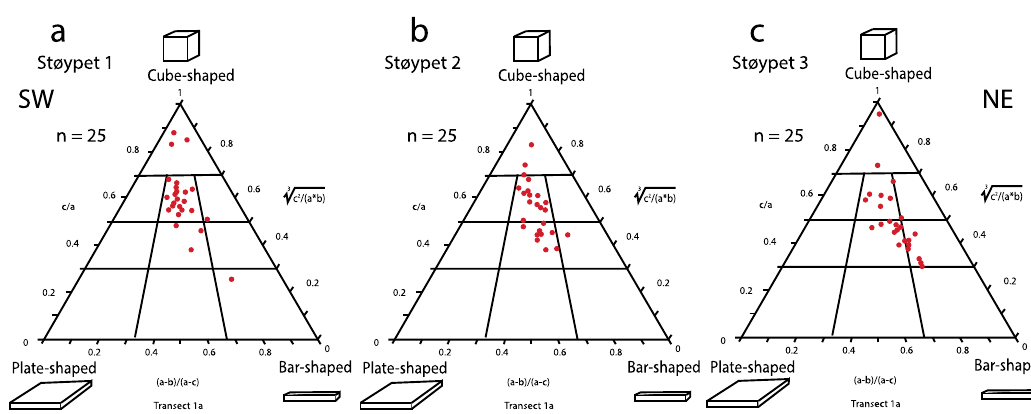
Figure 8. Set of triangular Sneed–Folk diagrams used to appraise variations in cobble and boulder shapes: ( a ) trend from sample 1 on the SW flank of Støypet, ( b ) trend sample 2 at the top, and ( c ) Trend from sample 3 on the NE flank of Støypet.